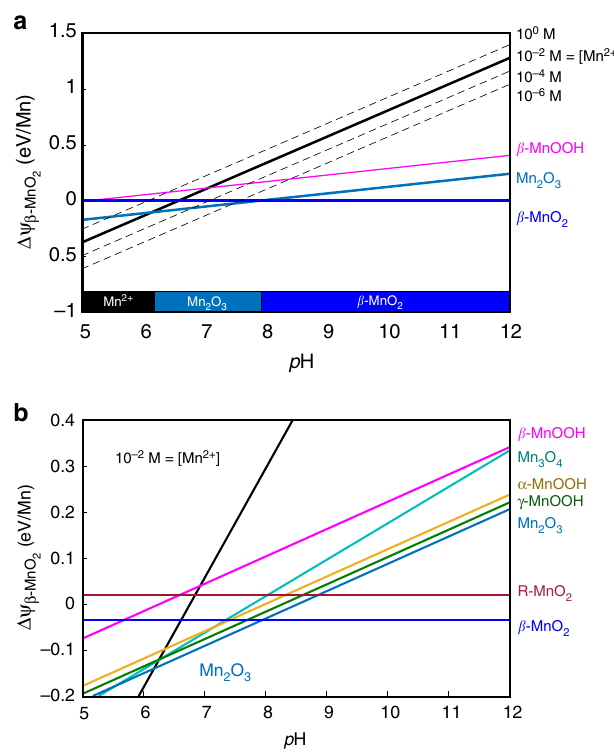
Fig. 3 Supersaturation of manganese oxides in solution. Shown for various pH at E = 0.5 V. a Pourbaix free-energy differences between the Mn 2 + (aq) ion and the β -MnO 2 phase, at varying [Mn 2 + ] concentrations (dashed lines). The projection of the lowest free-energy phases onto the pH axis marks the phase stability regions on the Pourbaix diagram. b Pourbaix free- energy differences between various solid phases and the β -MnO 2 phase, magni fi ed in the energy